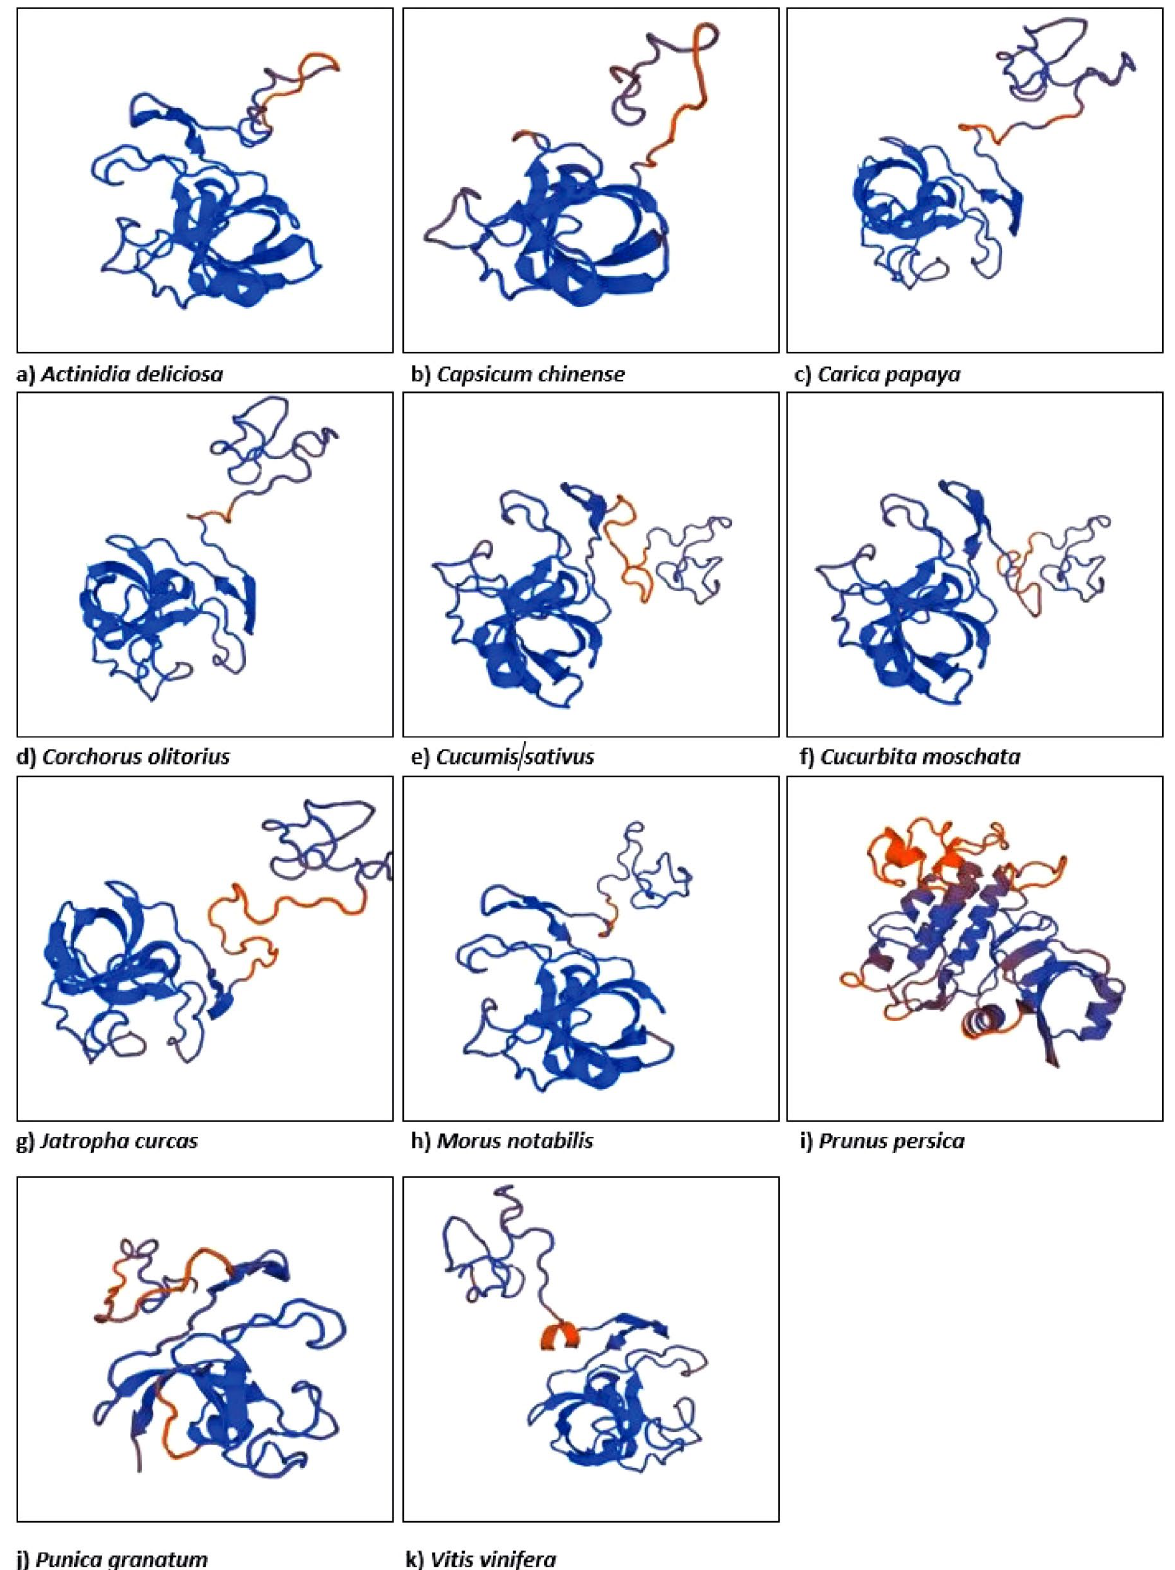
Figure 3 . 3-Dimensional visualization of each protein by Swiss-MODEL a) Actinidia deliciosa, b) Capsicum chinense, c) Carica papaya, d) Corchorus olitorius, e) Cucumis sativus, f) Cucurbita moschata, g) Jatropha curcas, h) Morus notabilis, i) Prunus persica, j) Punica granatum, k)Vitis vinifera (The name of the proteins in these species were given in Table 2)